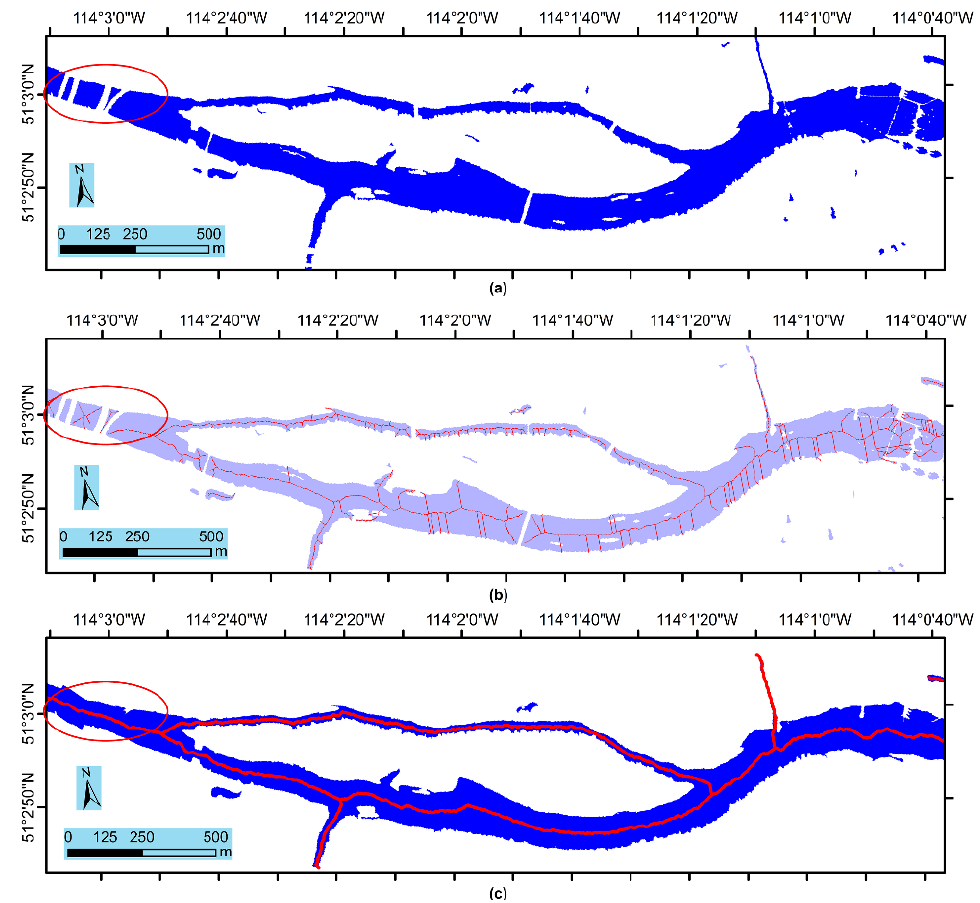
Figure 9. Centerline extraction and refinement using the morphological algorithm: ( a ) The water mask before river segment connection; ( b ) The centerline after thinning the refined water mask using morphological methods. This centerline is discontinuous and has many spurs; ( c ) The centerline extracted from the final water mask by thinning polygons and cleaning the spurs, over-draped on the final water